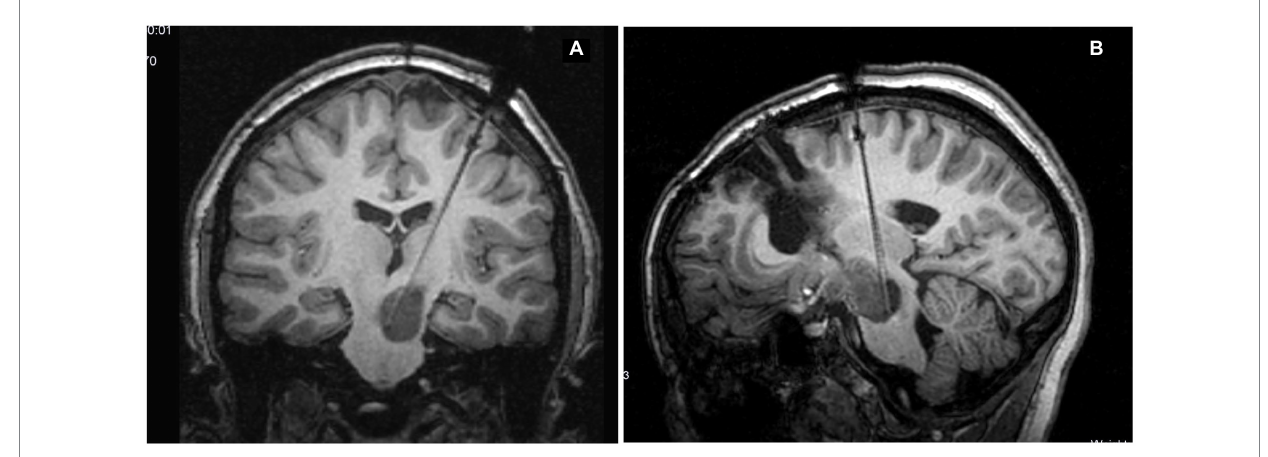
FIGURE 1 Slices chosen to be transferred to the Visualase system that are along the catheter trajectory (A) and orthogonal in position (B)